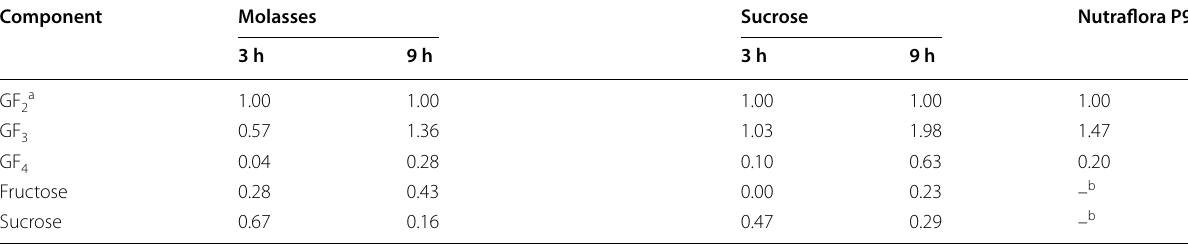
a The concentrations of GF 3 , GF 4 , fructose and sucrose were compared to the concentrations of GF 2 b Glucose, fructose and sucrose were not detected in Nutraflora P95